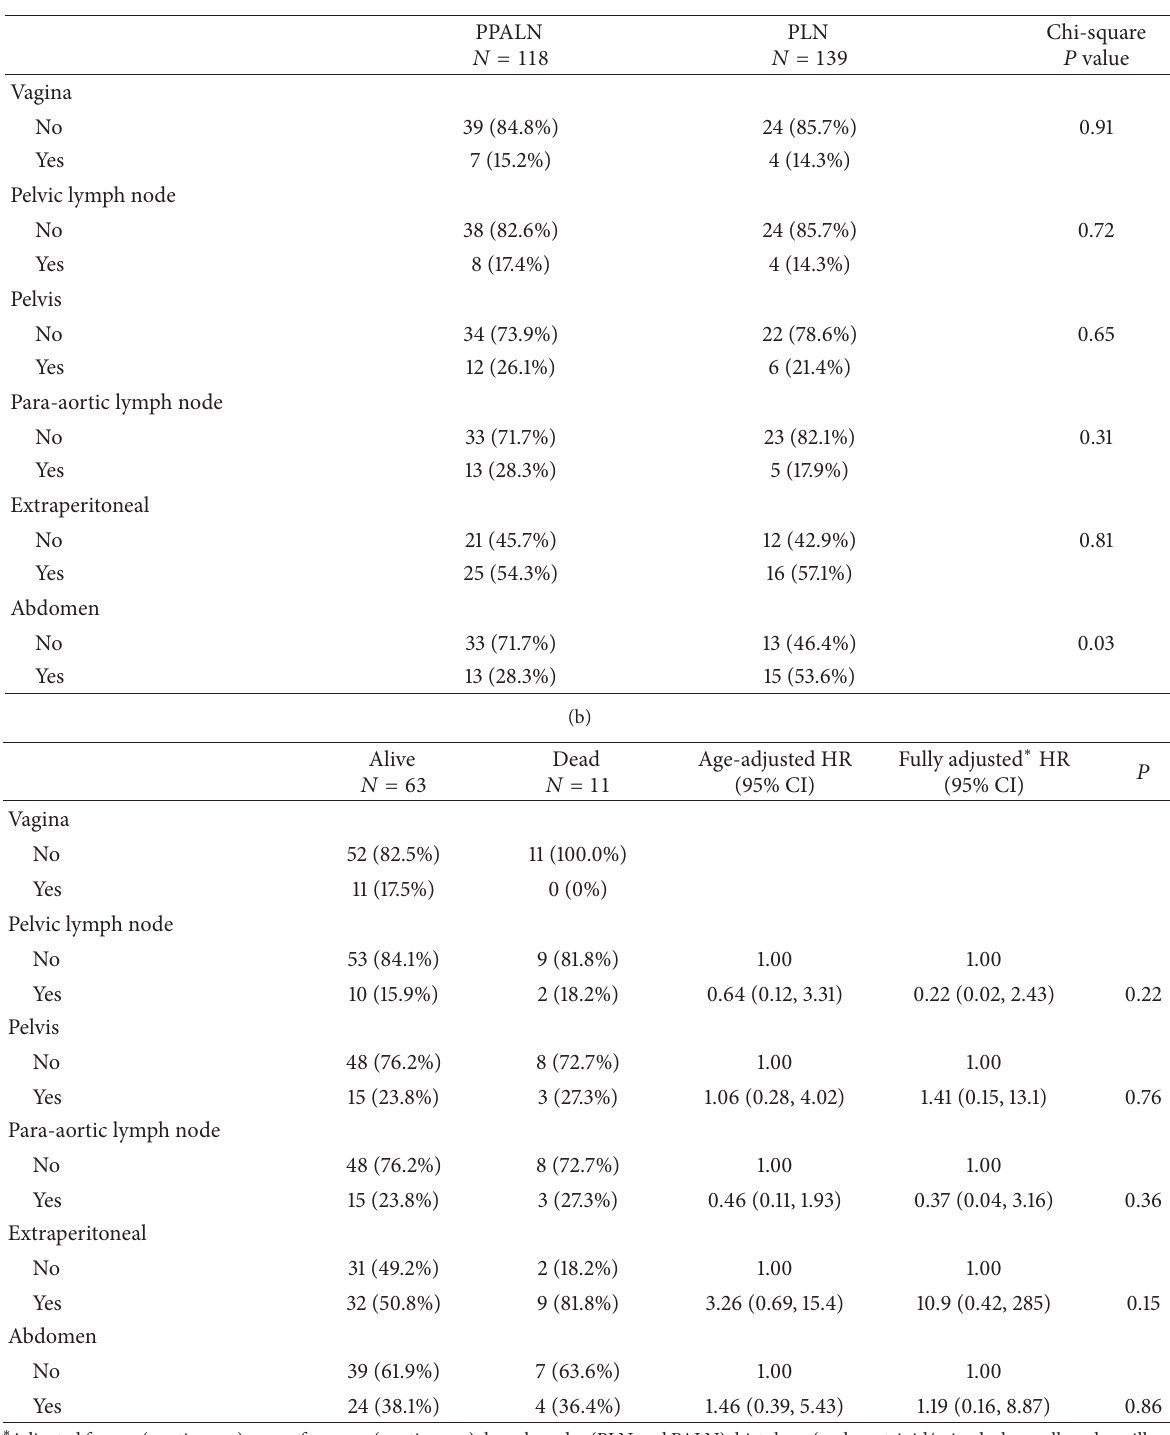
Table 4: (a) Disease recurrence patterns in the PPALN and the PLN groups. (b) Overall survival analysis adjusting for recurrence site amongst patients who experienced a recurrence ∗